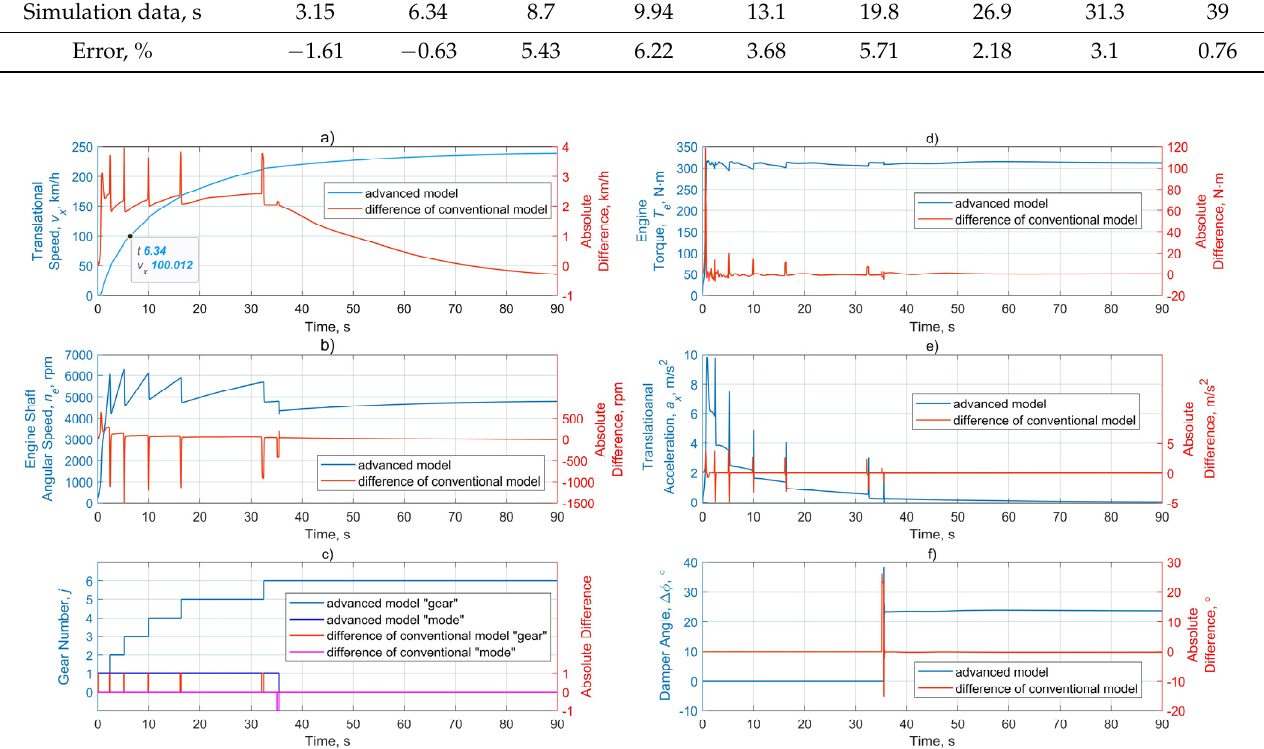
Figure 9. Performance parameters for two model variants with full fuel supply: ( a )—speed, ( b )—engine rpm, ( c )—gear shifting and TC’s clutch locking up, ( d )—engine torque, ( e )—acceleration, and ( f )—damper deformation angle.